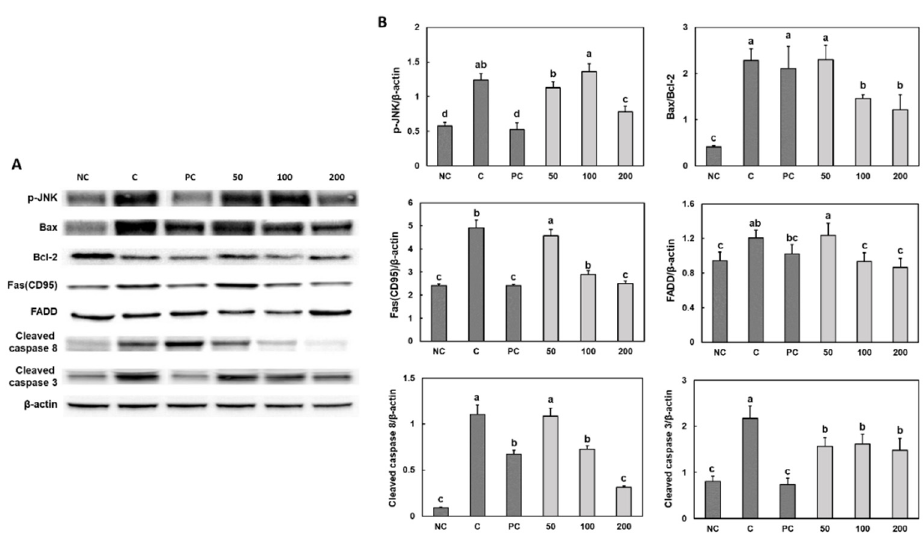
Figure 5. Effect of Gastro-AD ® on the apoptosis-associated factors ( A ), band image; ( B ), quantification of bands) in gastric damage induced by ethanol/HCl treatment in SD rats. Normal control (NC; − ethanol/HCl); ethanol/HCl control (C); ethanol/HCl with 30 mg/kg b.w. of rebamipide (positive control; PC); ethanol/HCl with 50 mg/kg b.w. of Gastro-AD ® (50); ethanol/HCl with 100 mg/kg b.w. of Gastro-AD ® (100); and ethanol/HCl with 200 mg/kg b.w. of Gastro-AD ® (200). Values are presented as mean ± SD ( n = 8). Different letters indicate a significant difference, with p < 0.05, as determined using Duncan’s multiple range test.